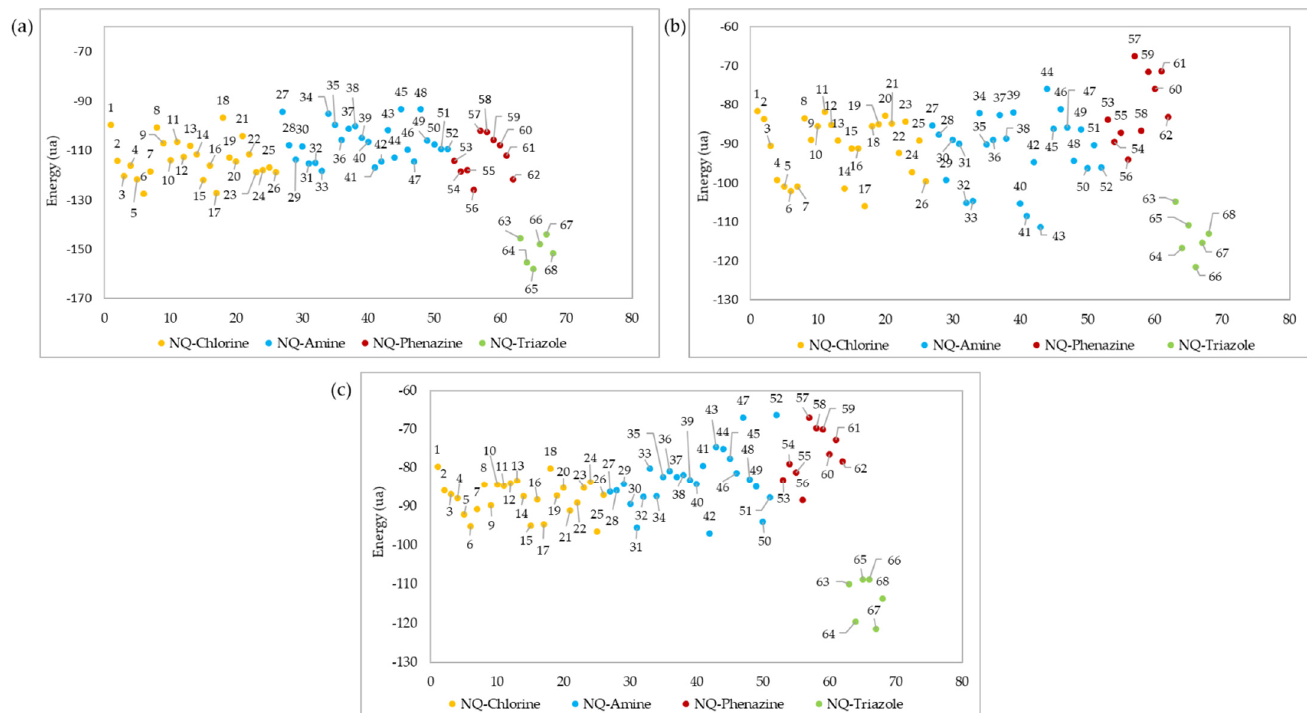
Figure 8. Ligand–protein docking energies of 1,4-naphthoquinone derivatives against ( a ) L Tr (Table S18), ( b ) La A (Table S19), and ( c ) Li AT (Table S20) receptors.